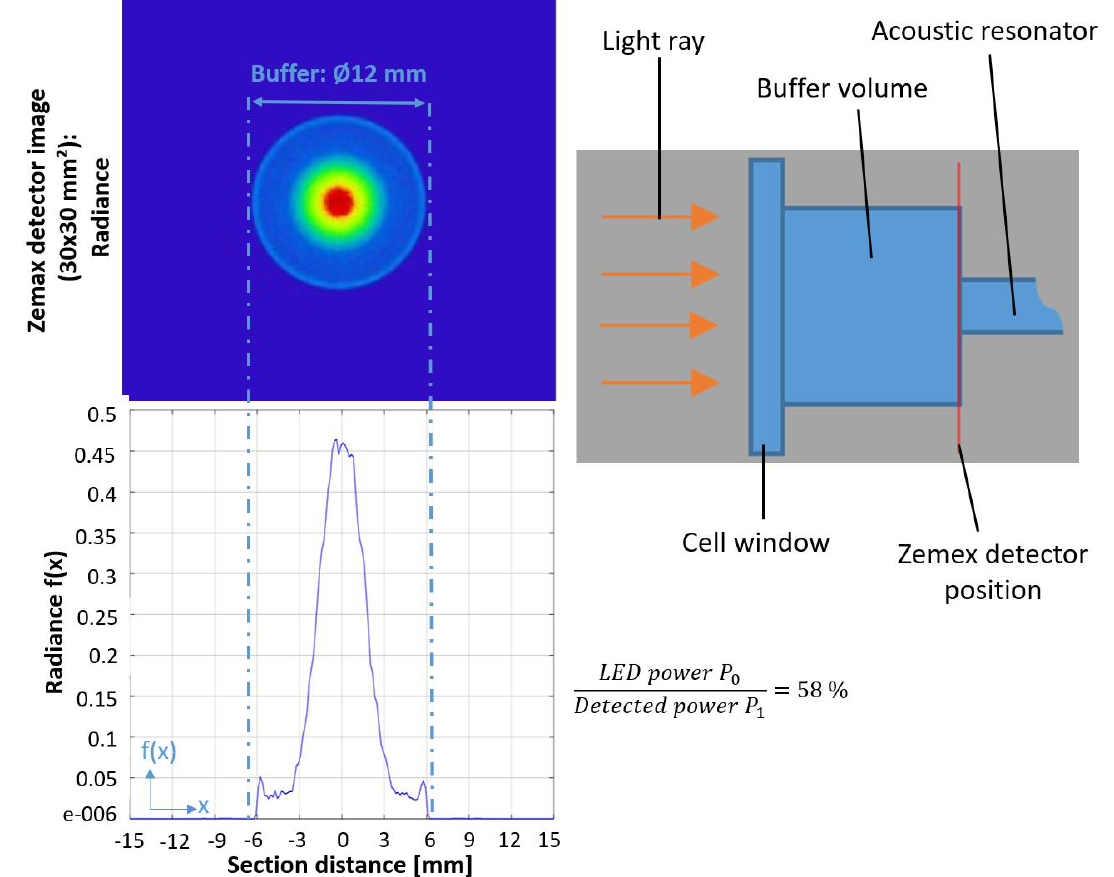
Figure 2. The ray-tracing simulation results with ZEMAX conducted at the entrance of the resonator (see simulation detector position in right schematic image). The focused beam diameter is clearly smaller than the buffer diameter (12 mm) and reaches a minimum diameter of around 2.8 mm before entering the photoacoustic resonator.